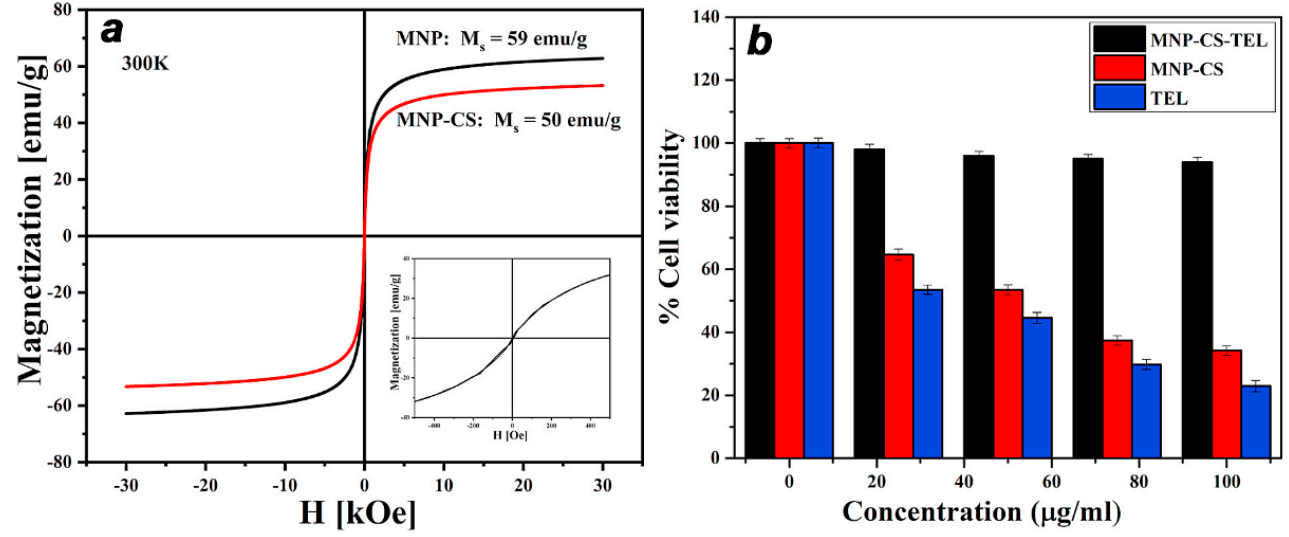
Figure 10. ( a ) Room temperature magnetization curves of MNPs and MNP-CS. ( b ) In vitro cytotoxicity assay of MNP-CS, MNP–CS–TEL, and TEL on PC-3 human prostate cancer cell line by MTT assay. Reprinted from ref. [366], with permission from Elsevier, 2021.